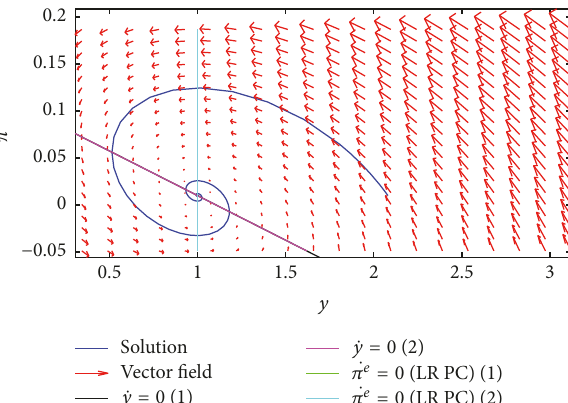
Figure 9: Fiscal policy shock. (a) Solution for 𝑦(𝑡) . (b) Solutions for 𝜋(𝑡) and 𝜋 𝑒 (𝑡) .